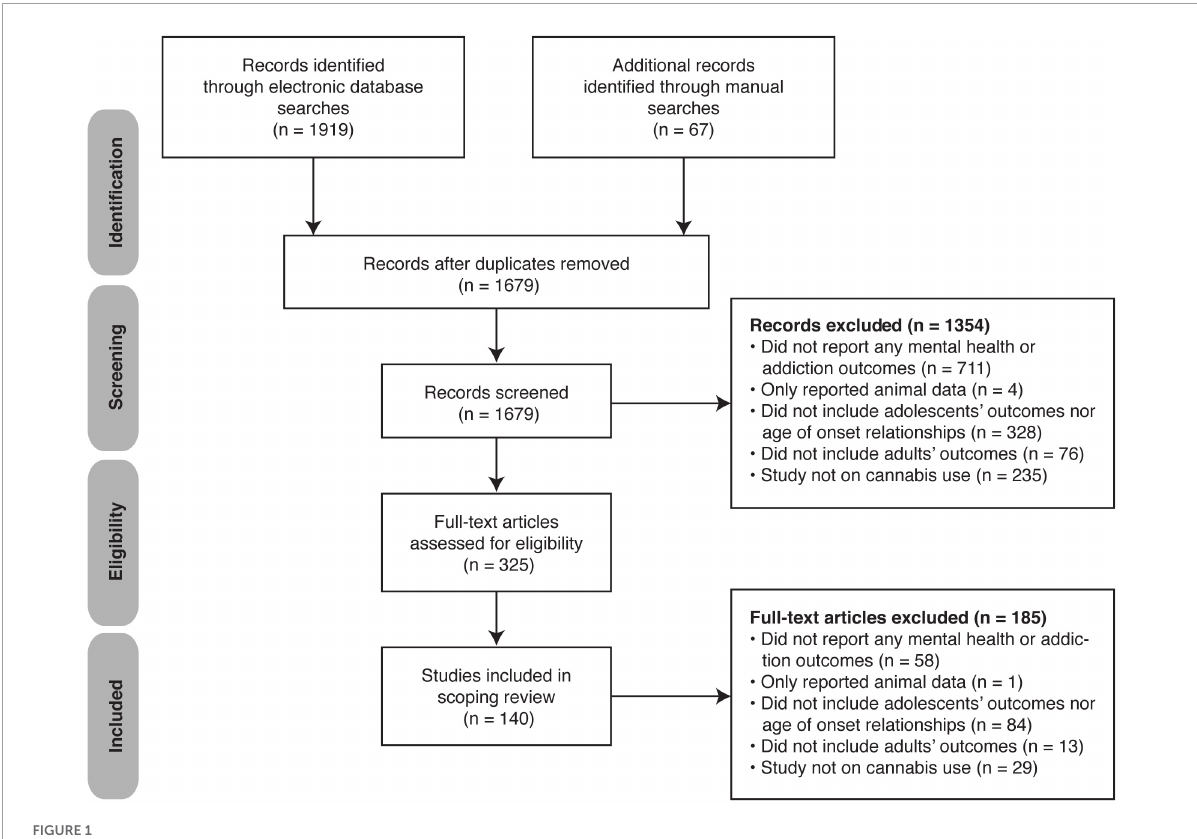
FIGURE1 PRISMA flow diagram of the search and study selection